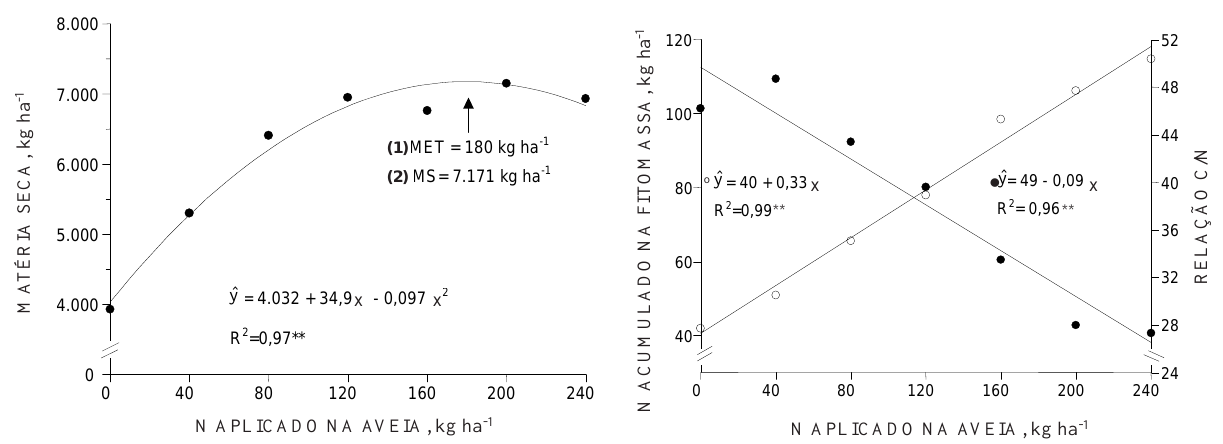
Figura 1. Produção de matéria seca de acordo com as doses de N aplicadas na aveia preta, na média dos anos de 1998 a 2000. (1) MET = Máxima eficiência técnica. (2) MS = Matéria seca de aveia.